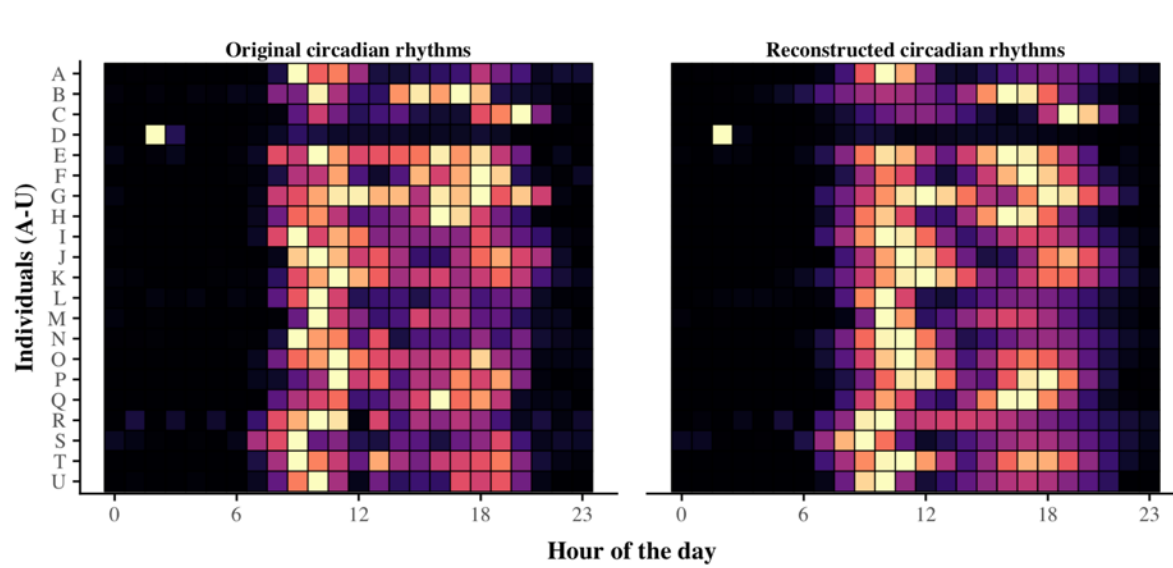
Figure 2. Circadian rhythms of outgoing telephone call activity in older adults and their corresponding Gaussian mixture models (GMMs). These patterns are represented by means of two colored heat maps, where each line corresponds to one older individual and columns correspond to hours of the day. Hence, the outgoing telephone call activity of one individual at a given hour is represented by a colored cell that is all the more bright as the individual increases activity. The left-hand heat map represents the original circadian rhythms of outgoing telephone call activity observed from empirical data, whereas the right-hand heat map represents those modeled by